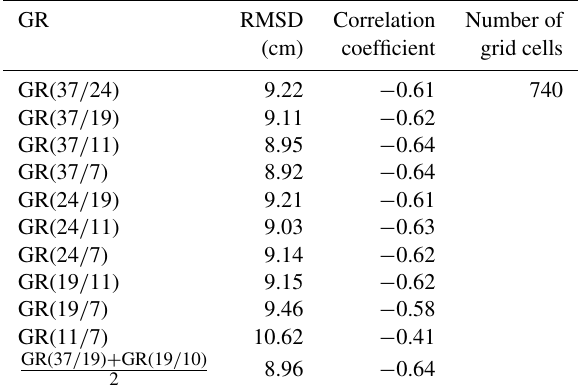
Table 1. The relationships (including RMSD and correlation coef- ficient) between the OIB snow depth and different